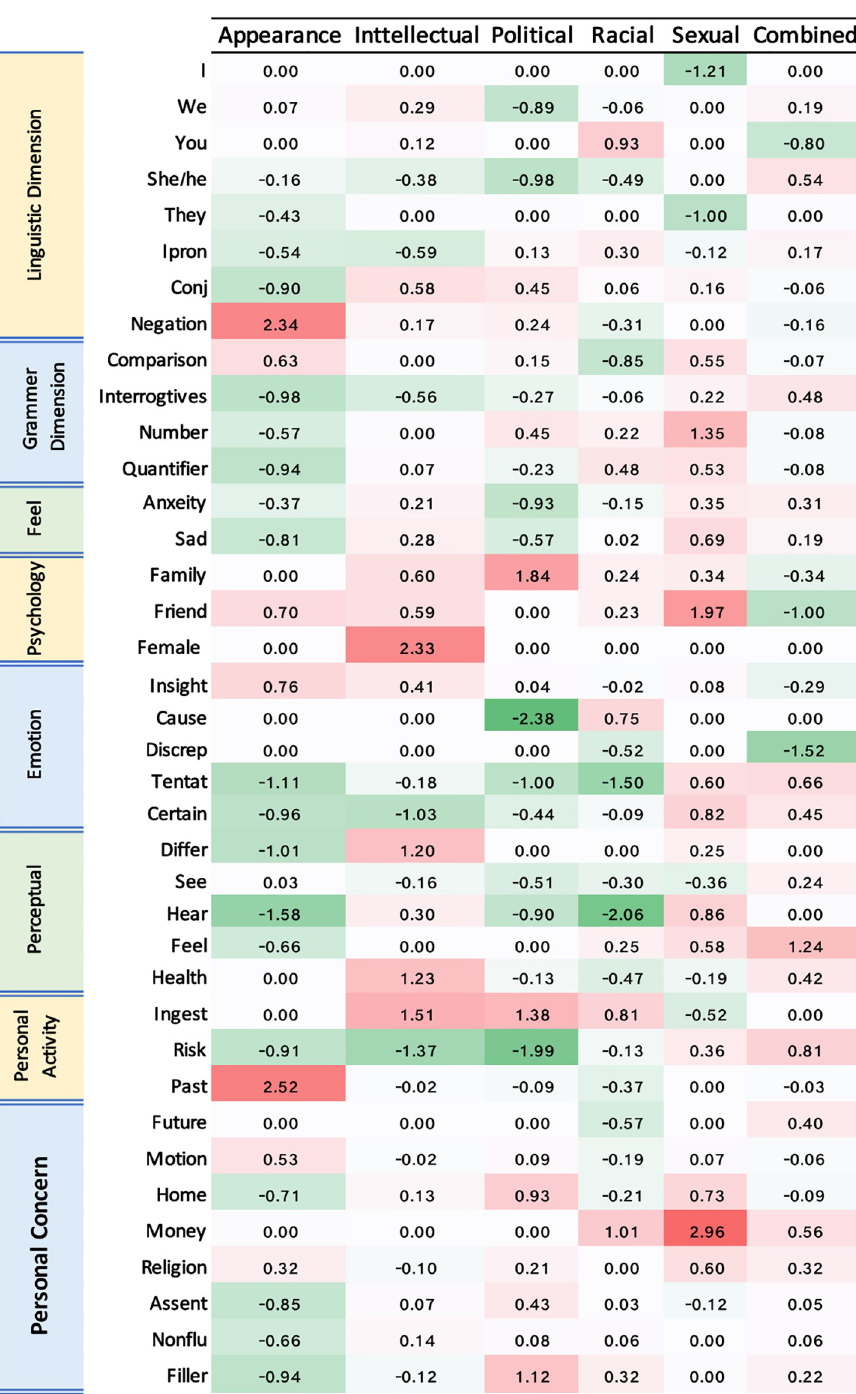
Fig 2. Significant LIWC features in comparing harassing corpus to non-harassing corpus for six categories. The extreme red (green) color indicates the significance of a given feature in the harassing corpus (non-harassing corpus). E.g. the negation feature with the value 2.34 in the appearance harassing corpus is significantly higher than non- harassing corpus. The white color indicates a lack of difference for a given feature when comparing two corpora.